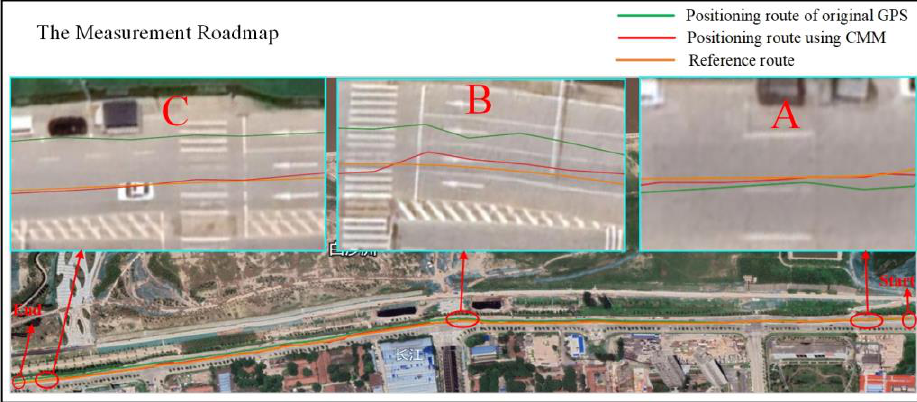
Figure 13. Dynamic positioning result reproduced on Google Earth.